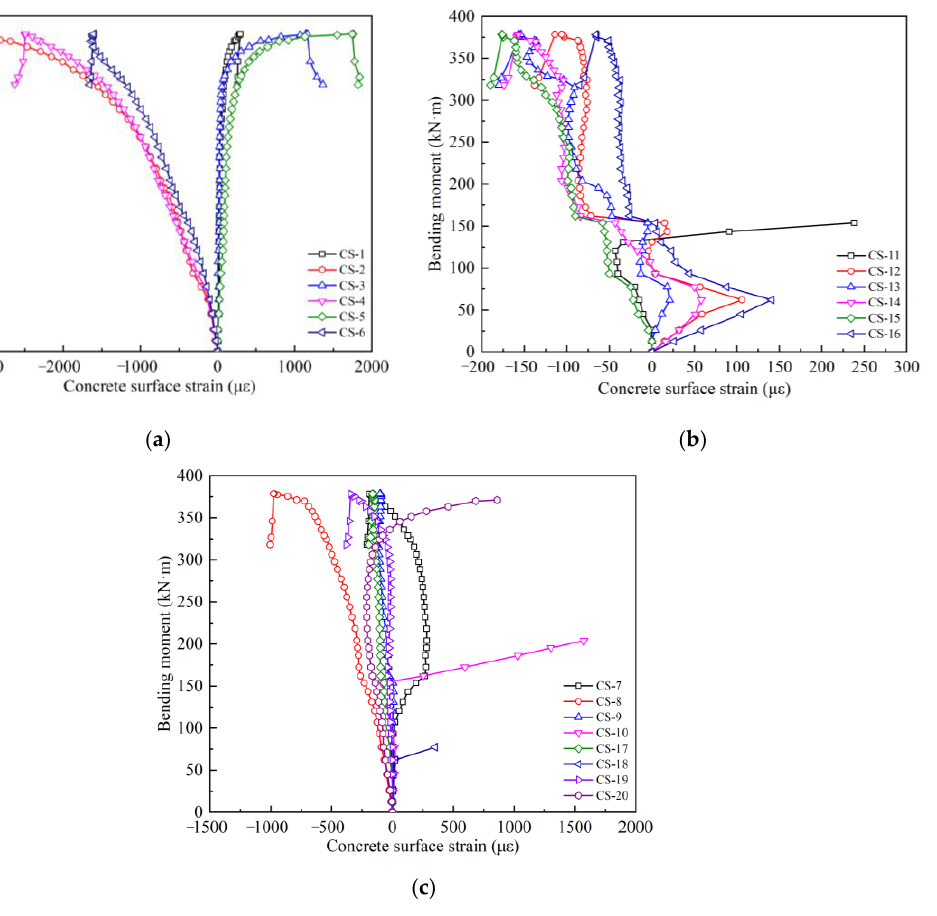
Figure 13. The bending moment–concrete strain relationship curves of 1/2 section: ( a ) monitoring points on top surface, ( b ) monitoring points on the bottom surface, ( c ) monitoring points on front and back